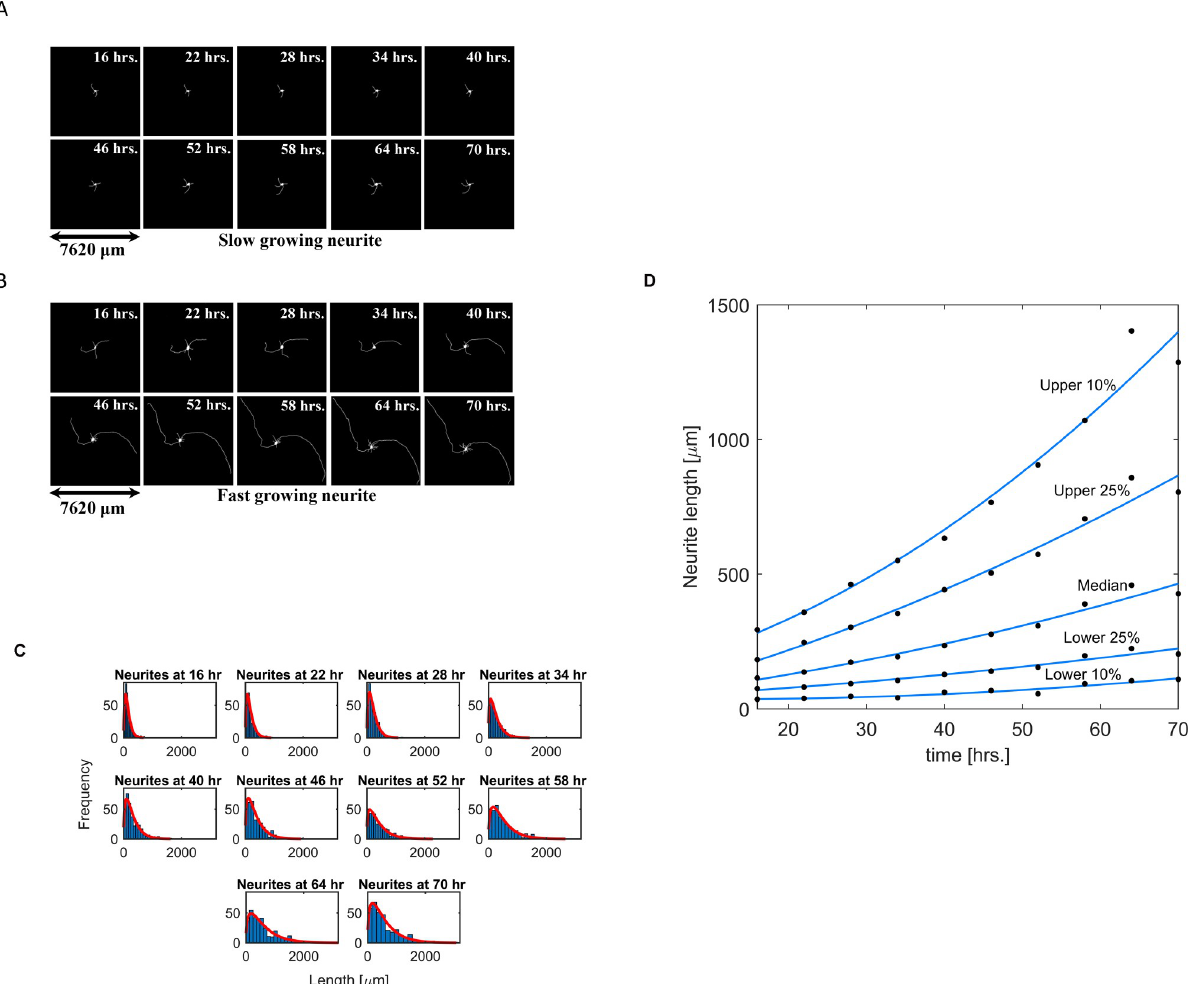
Fig 3. Neurites grow with different outgrowth velocities. Neurons were dissected from rat cortical brain, incubated for 16h to allow initial growth, and followed by image acquisition every 6h up to 70h after plating. (A-B) The growth dynamics of two example neurons, one with a low (A) and one with a high (B) outgrowth velocity, are shown over given time-period. (C) At each timepoint we quantified the length of the longest neurite of each neuron. Histograms show the length distribution of all longest neurites at the indicated timepoints. (D) At each timepoint we identified the top and bottom 10% and 25% quantile length as well as the median length. Exponential interpolation of the lengths for each selected quantile documented outgrowth velocities ranging from 0 to ~20 μ